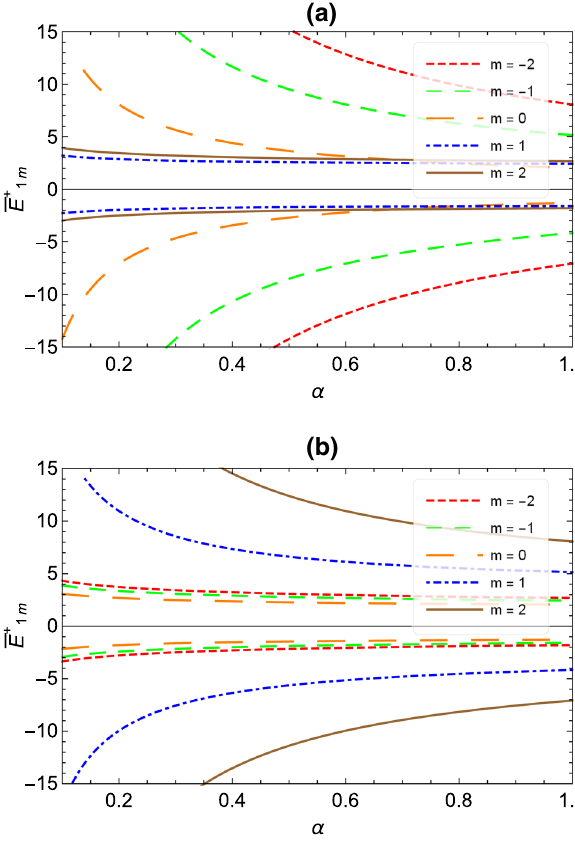
Fig. 4 Illustration of the energy levels in the pseudo-spin symmetry (cid:9) (cid:8) E − limit, , as a function of the parameter α for the particular case 1 m p when η L = 0. In a the plot for s = 1 and b for s = − 1. We use M = 1 and η C = 1. In a the energy of the states are not defined when the parameter α is 0 . 25 (dashed-long orange line), 0.42 (dashed-dot blue line) and 0.59 (solid brown line). The energy of the state with m = − 2 (dot red line) changes very slowly and it shows no degeneracy. The spectrum is more energetic near the points of singularity and less energetic near α = 0 . 1 and α = 1, respectively, except the m = − 1 curve (dashed green line), which is more energetic only near α = 0 . 1.